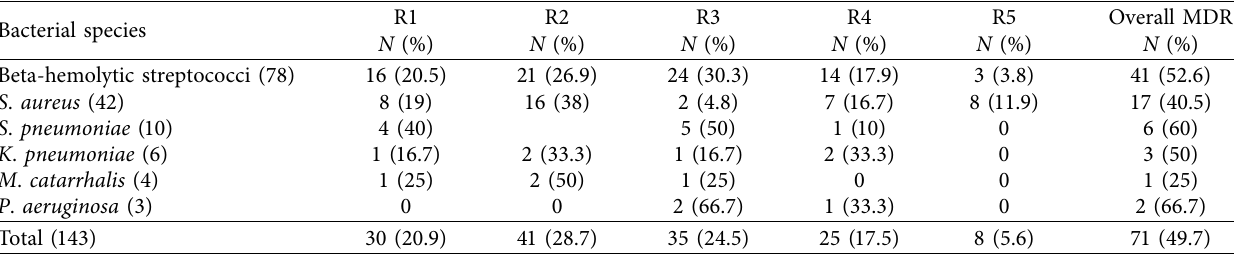
Table 6: Multidrug resistance profles of bacterial isolates from children 2–5 years of age with suspicion of bacterial tonsilitis at Hargeisa Group of